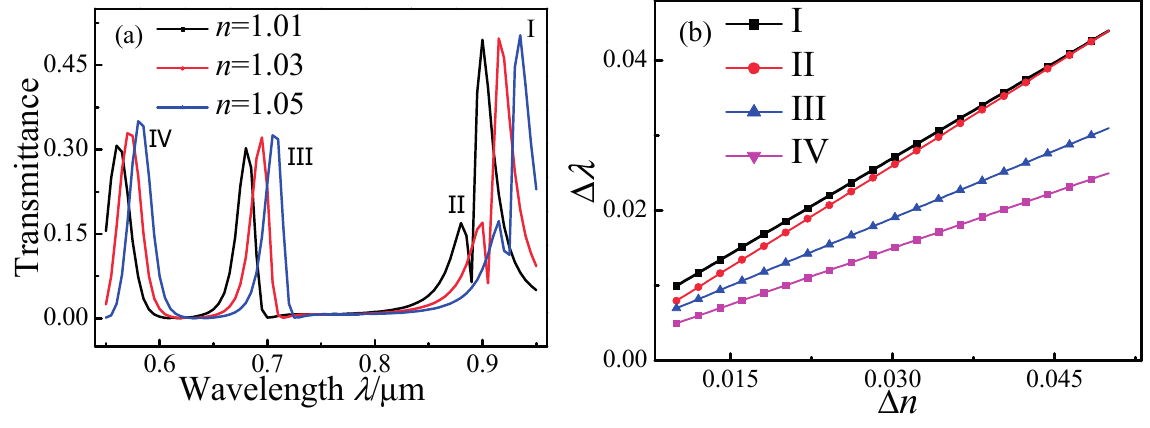
Figure 8. Transmission spectra of MIM waveguide-coupled ring resonators containing various dielectrics with refractive index n . ( a ) Spectra for structures containing dielectrics with n = 1.01, 1.03, and 1.05; ( b ) Peak red shifts as a function of Δ